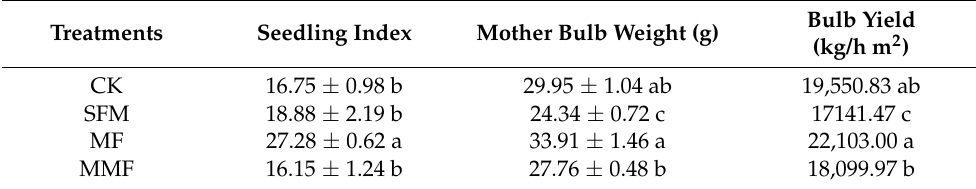
Table 1. The lily growth status of Lanzhou lily rhizosphere soil among different treatments: The seedling index was calculated at lily flowering stage in July 2019; Mother bulb weight means the seed bulb weight after it had grown for 1 year, and it was evaluated in October 2019; Bulb yield referred to the bulb weight after it had grown for 3 years, and it was evaluated from all the plants in each plot in October 2021: the significance is 0.05 for lower letters (a, b, c) presented in table. Bulb Treatments Seedling Index Mother Bulb Weight (g)